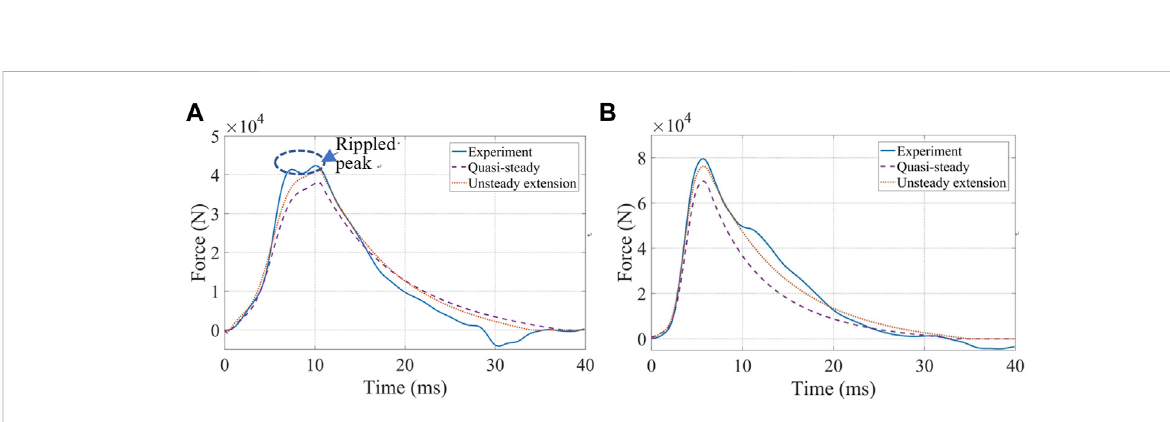
FIGURE 8 The force between the experiments and the models at 3.0 A: (A) 1.5 m/s; (B) 3.0